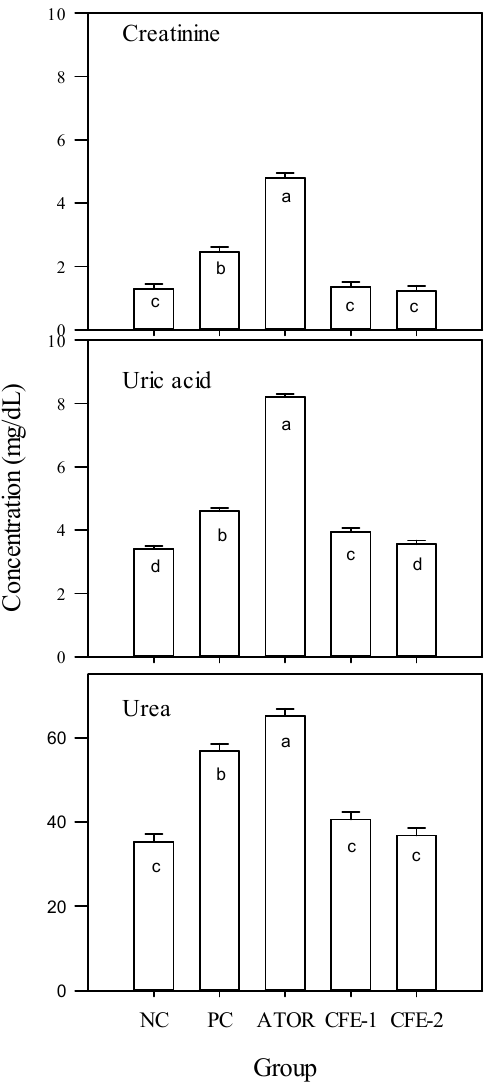
Figure 6. Creatinine, uric acid, and urea in the serum of male Albino rats during the 9-week study period. Group 1 received a normal diet and served as a negative control (NC). Groups 2–5 received a high-fat diet, where group 2 did not receive any further treatment (positive control: PC). Group 3 was treated with atorvastatin (10 mg kg − 1 ), while groups 4 and 5 were treated with Lactobacillus paracasei postbiotic (CFE-1 and CFE-2; at 100 and 200 mg kg − 1 , respectively). Values are presented as mean ± SD ( n = 8). Mean values within the same histogram with different superscripts letters are significantly different ( p < 0.05). Forty animals were divided into five groups (8 animals each). Postbiotic is the cell-free extract (CFE).